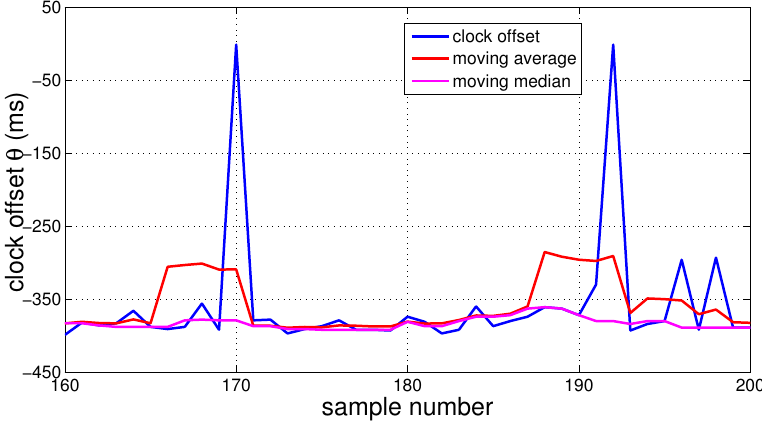
Figure 7. NTP clock offset, moving mean and median filtered signals. Window-size = 5 samples.